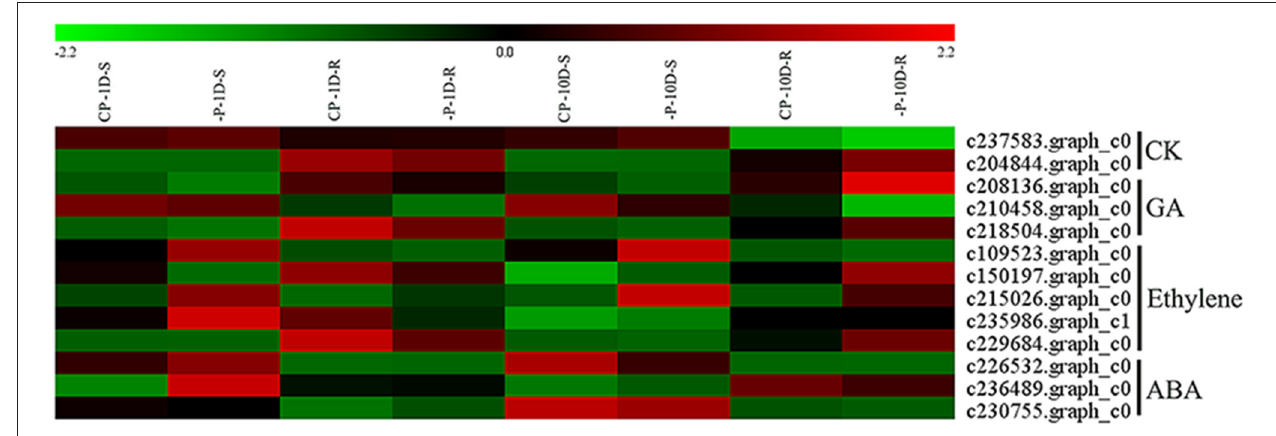
FIGURE 4 | Heatmap of the DEGs involved in hormone synthesis. Expression, represented by Z scores, is shown for selected DEGs due to -P conditions. Red indicates high expression, black indicates intermediate expression, and green indicates low expression.